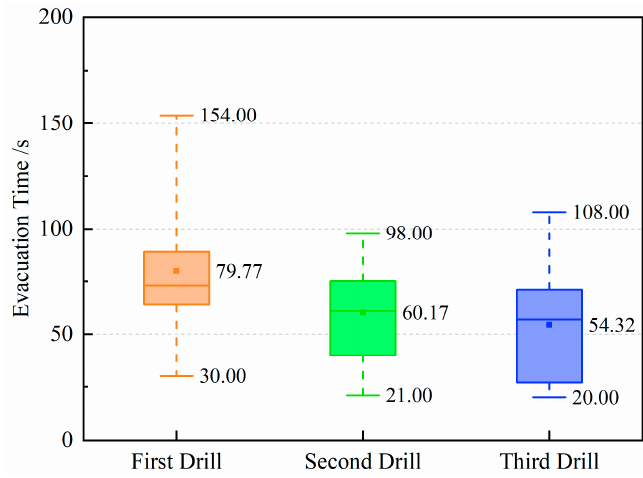
Figure 10. Evacuation time of three drills.